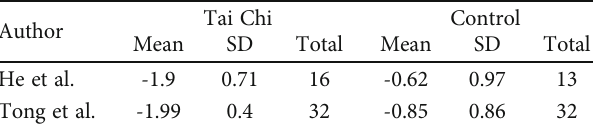
Table 5: Pain intensity of Tai Chi vs. control.